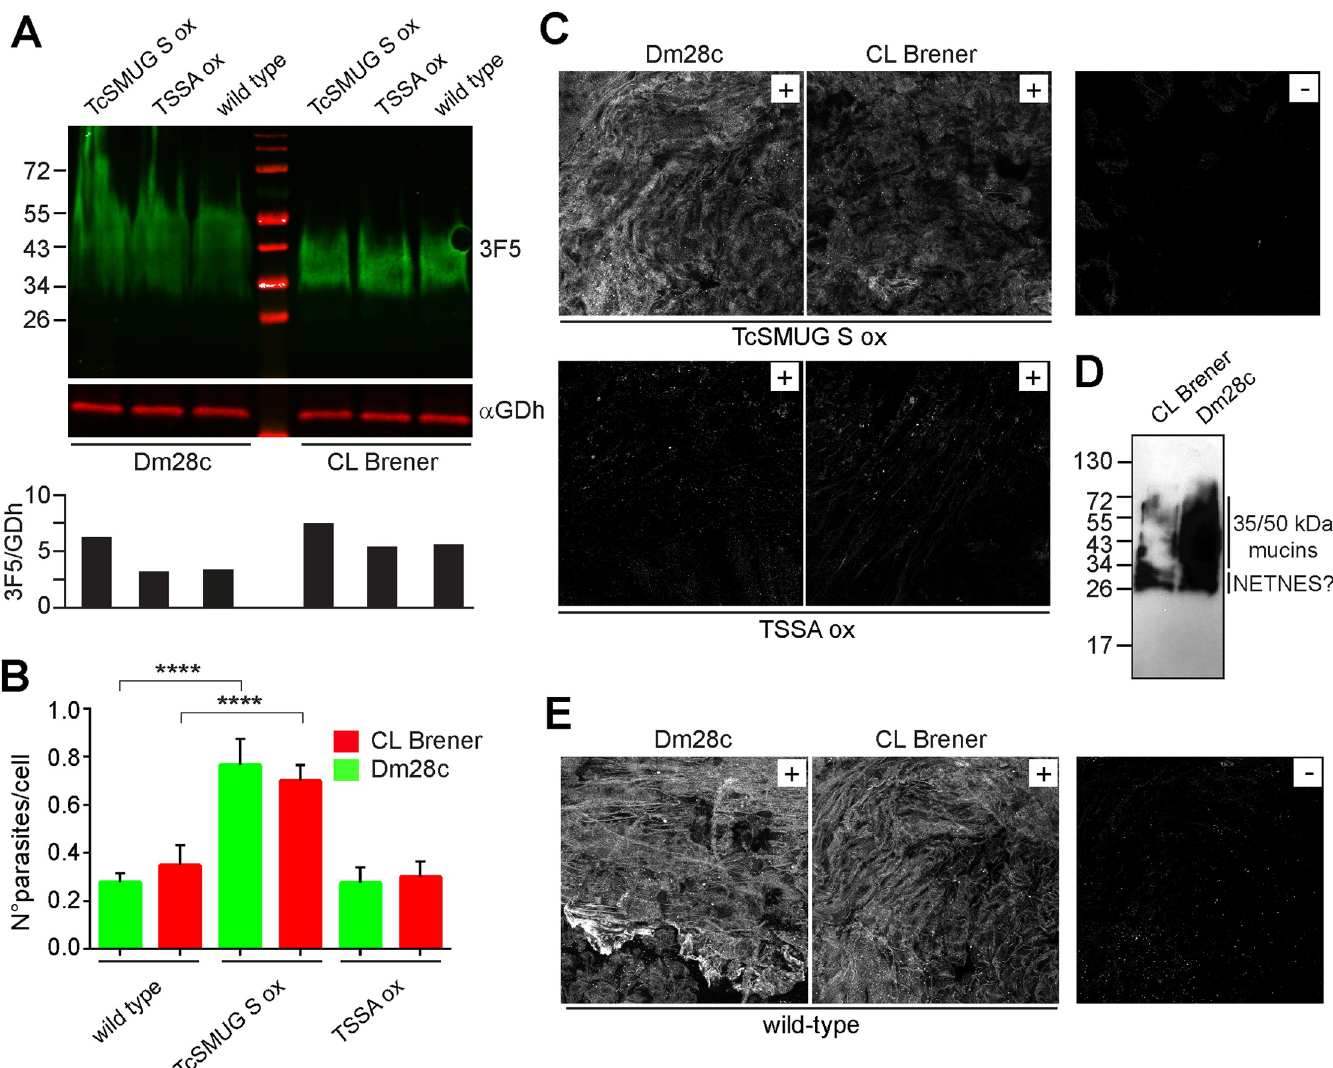
Fig 2. Binding of T . cruzi Gp35/50 kDa mucins to T . infestans rectal ampoule. A) Total lysates from TcSMUG S ox, TSSA ox and wild-type epimastigotes from either CL Brener or Dm28c clone were analyzed by Western blot using mAb 3F5 and anti- T . cruzi glutamate dehydrogenase serum ( α GDh). The ratio between both signals (3F5/GDh) was calculated by densitometric analyses (lower panel). B) Rectal ampoules obtained from T . infestans fifth-instar nymphs 12–15 days after the last bloodmeal were incubated with 2 x 10 3 epimastigotes from the indicated line, and the number of adhered parasites per 100 epithelial cells were counted in 10 different fields of each tissue preparation. For each experimental group, 10 insects were used and experiments were performed in triplicate. Data are expressed as mean ± S.D. and asterisks denoted significant differences between the population means ( P < 0.0001) assessed by ANOVA and Tukey’s tests. C) Confocal laser microscopy of the inner surface of rectal ampoules of T . infestans incubated with total lysates from the indicated transgenic line, followed by mAb anti-FLAG-based indirect immunofluorescence (IIF) assay. A control staining of the anti-FLAG mAb in the absence of parasite lysate is shown (-). D) Delipidated wild-type epimastigotes from CL Brener or Dm28c clone were extracted with butan-1-ol, and fractions enriched in glycoconjugates were analyzed by SDS-PAGE and periodate-Schiff staining for carbohydrates. The positions of relative molecular mass markers (in kDa) are shown. E) Confocal laser microscopy of the inner surface of rectal ampoules of T . infestans incubated with glycoconjugates from the indicated parasite clone followed by mAb 3F5-based IIF assay. Control staining of mAb 3F5 in the absence of glycoconjugates is shown (-).